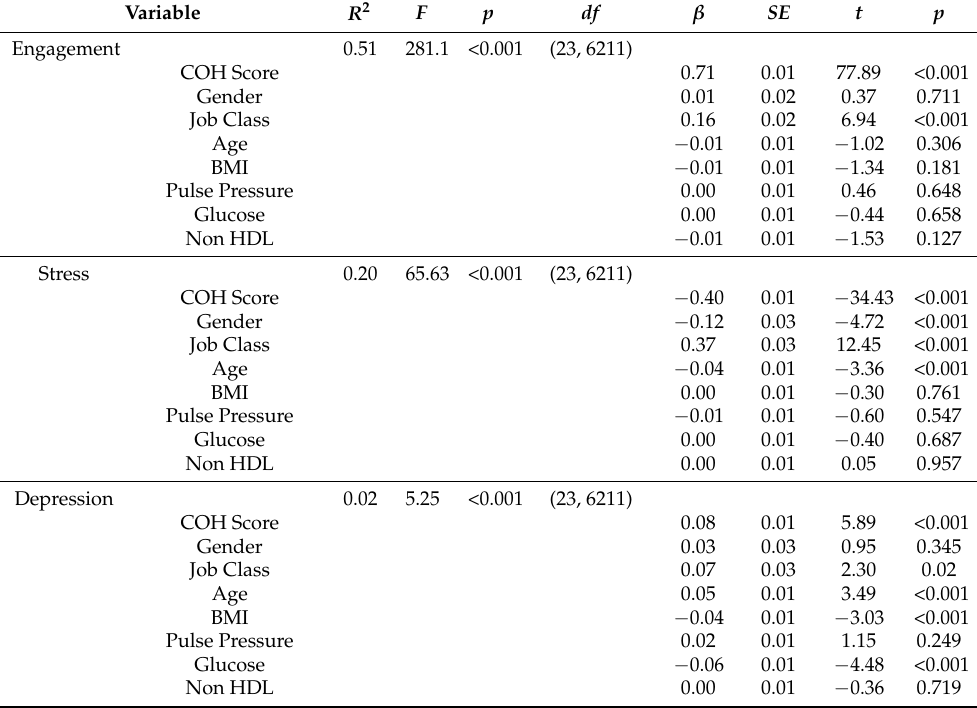
Table 3. Results of linear regression model with COH score as the main predictor variable.